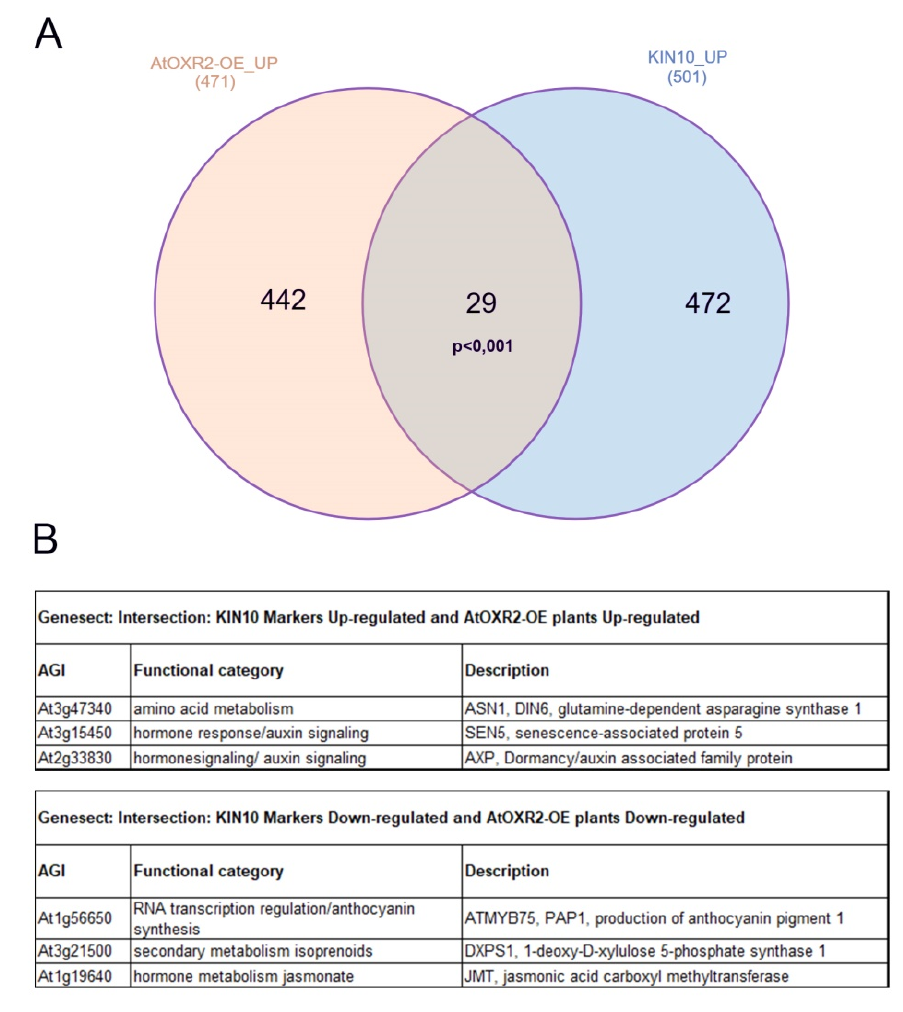
Figure 8. ( A ) Analysis of the interaction between the AtOXR2-mediated pathway [39] and KIN10 (=SnRF1) regulated genes [57]. The interaction was plotted using the Interactivenn tool (http://www.interactivenn.net/, accessed on 10 November 2021) [50]. See Table S2 for the list of 29 genes statistically shared ( p < 0.001) by both datasets. ( B ) List of KIN10 (=SnRF1) gene markers statistically represented as co-regulated genes in AtOXR2-OE plants and protoplast transiently expressing KIN10 . Genesect interaction is a bioinformatic tool at the Virtual Plant system database (http://virtualplant.bio.nyu.edu/10 November 2021) [49].